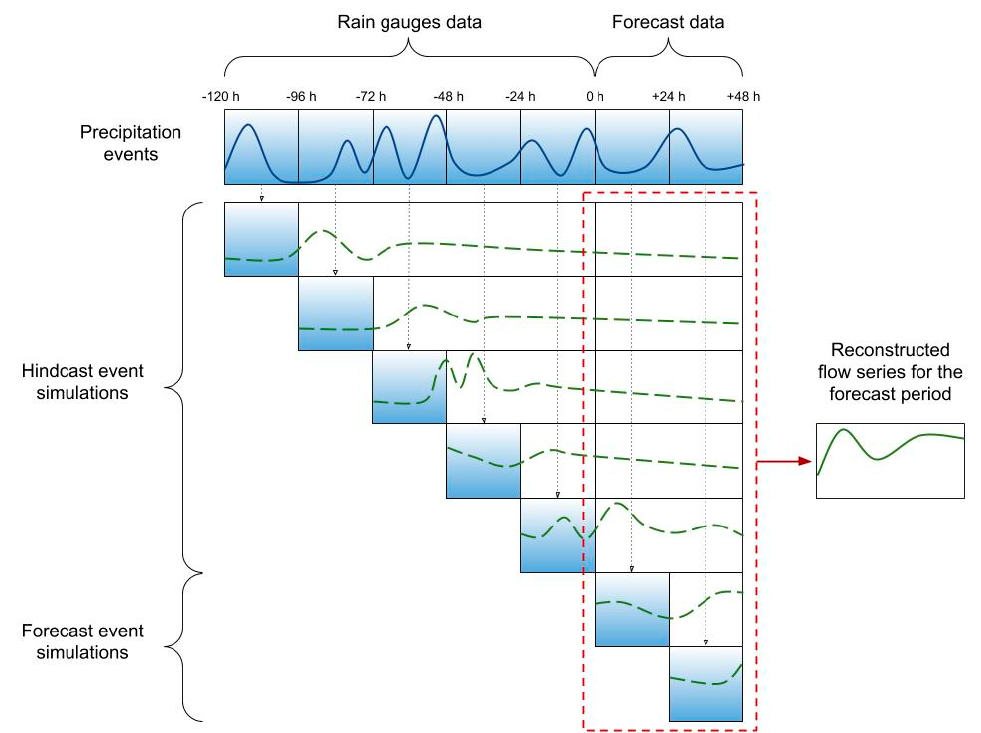
Figure 3. Procedure for the reconstruction of the sub ‐ basin outflow series.